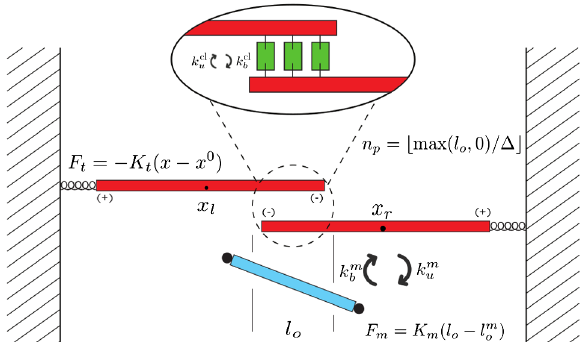
FIG. 2. One-dimensional “ force dipole ” actomyosin model schematic. Two filaments with plus ends facing outward and midpoints x and x are both connected to springs with stiffness r l K , initially with an equilibrium filament position of x 0 and x 0 . t r l When no cross-linkers are bound between the two filaments, they separately undergo tethered Langevin motion. While the filament overlap l is large enough, cross-linkers can transiently bind and o unbind according to their kinetic rates as in Eq. (2), which arrests the filaments if the number of cross-linkers bound is nonzero.The number of available binding sites n varies with actin filament p overlap. Motor filaments can (un)bind and walk stochastically on the pair of actin filaments, generating force via a time-varying filament overlap